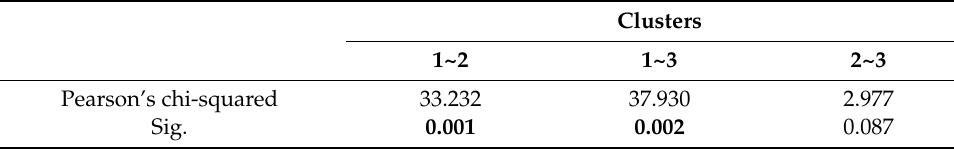
Table 5. Pearson’s chi-squared tests.